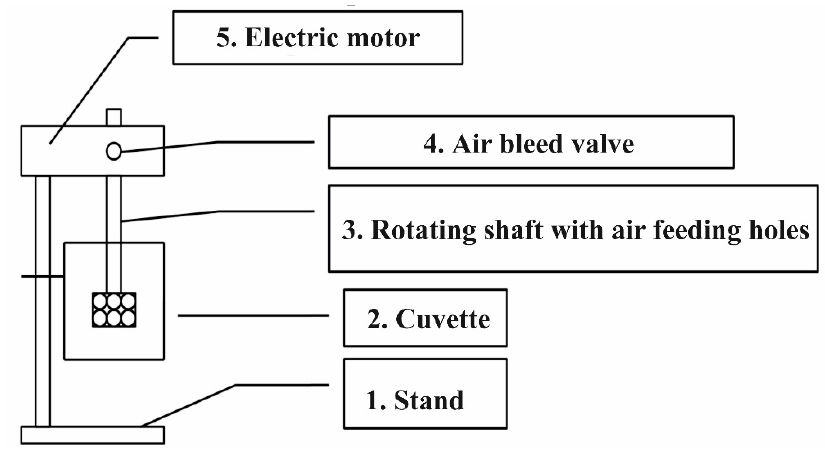
Figure 2. A diagram of the B- ΦЛ 137 flotation machine.